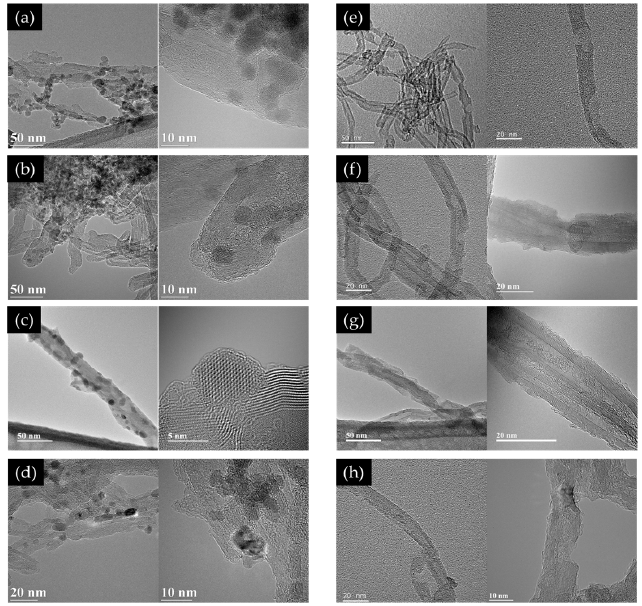
Figure 3. TEM images of ( a – d ): MWCNT@metal oxide NP composites; ( e – h ): multi-vacancy-defect MWCNTs after the removal of metal oxide NPs.